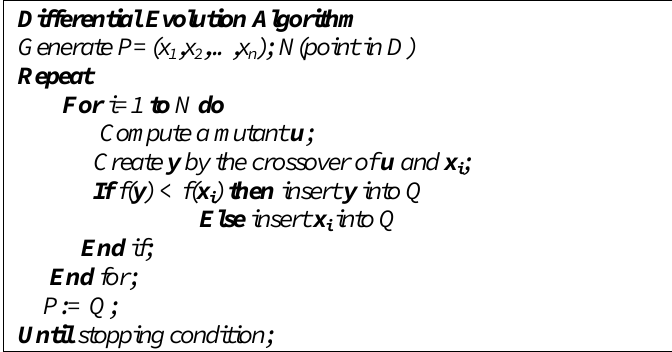
Fig. 1. Pseudo-code of the DE